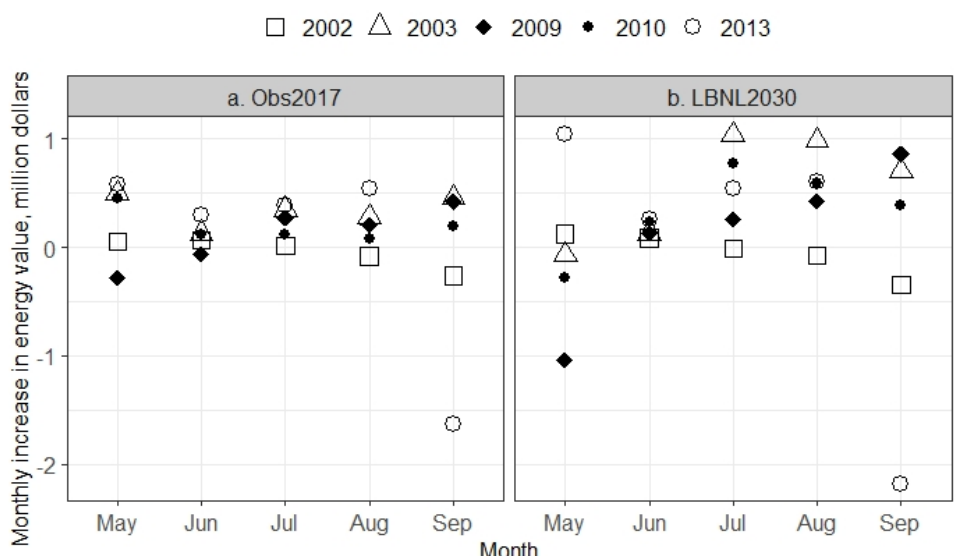
Figure 8. The monthly increase in energy value (“enhanced forecasting method”–“statistical”) of the selected years under two price scenarios.